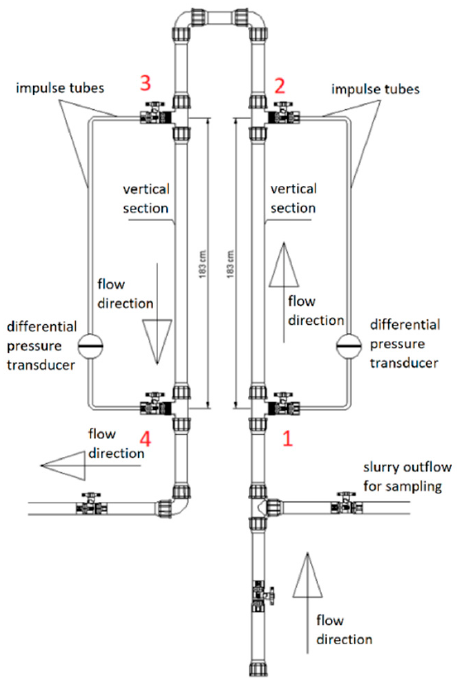
Figure 3. Scheme of the installation of the hydraulic densimeter. 1-4 pressure sampling points.